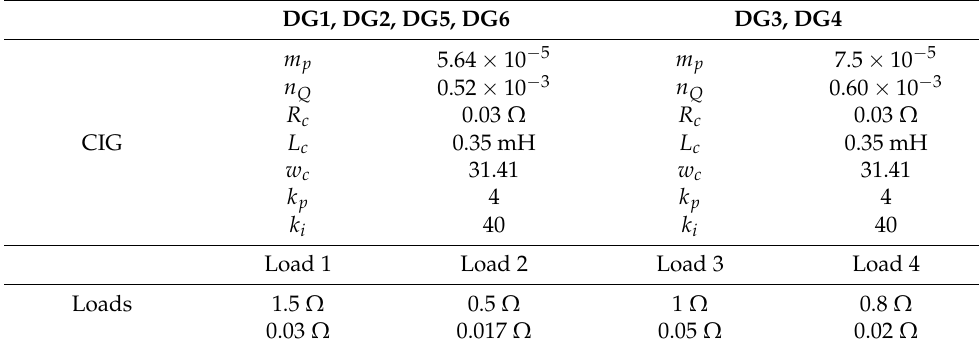
Figure 4. A modified IEEE 34-bus test feeder with six inverted-based DGs. Table 1. Specifications of the IEEE 34-bus feeder